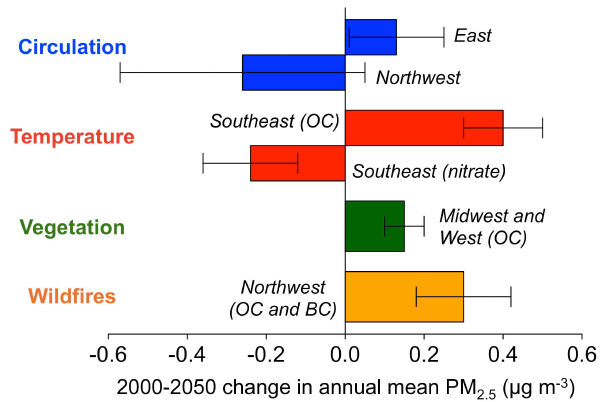
Fig. 8. Summary of projected effects of 2000–2050 climate change on annual PM 2 . 5 in the US as driven by changes in circulation, temperature (biogenic emissions and PM volatility), vegetation dy- namics, and wildfires. The affected regions and PM 2 . 5 components are identified (OC ≡ organic carbon; BC ≡ black carbon). Error bars represent either the approximate range or standard deviation of the estimate. Estimates are from this work (circulation); Tagaris et al. (2007), Heald et al. (2008) and Pye et al. (2009) (temperature); Wu et al. (2012) (vegetation); Spracklen et al. (2009) and Yue et al. (2012) (wildfires). All studies used the IPCC SRES A1B sce- nario for 2000–2050 climate